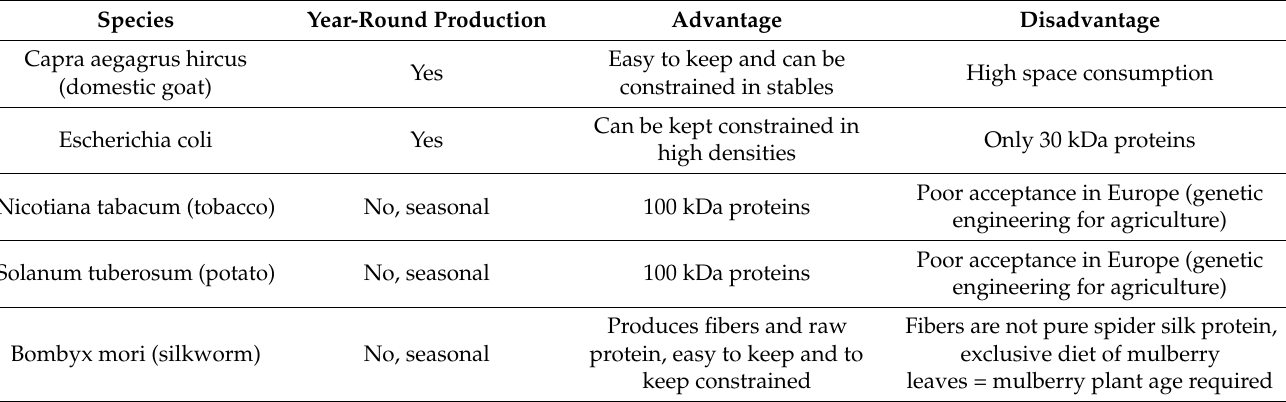
Table 5. List of organisms successfully modified to produce spider silk protein